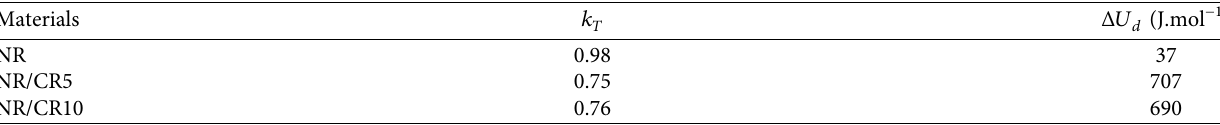
Table 6: Δ U d of NR and NR/CR blends after mechanical aging.